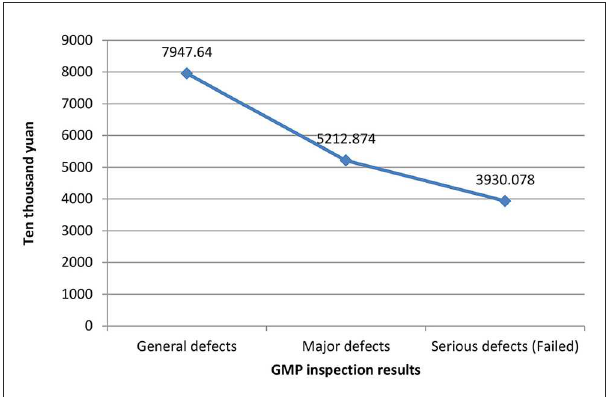
FIGURE1 Fixed assets values and GMP inspection results.